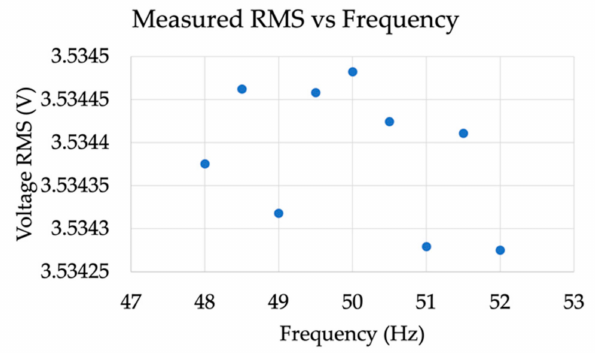
Figure 9. RMS vs. frequency of results in Table